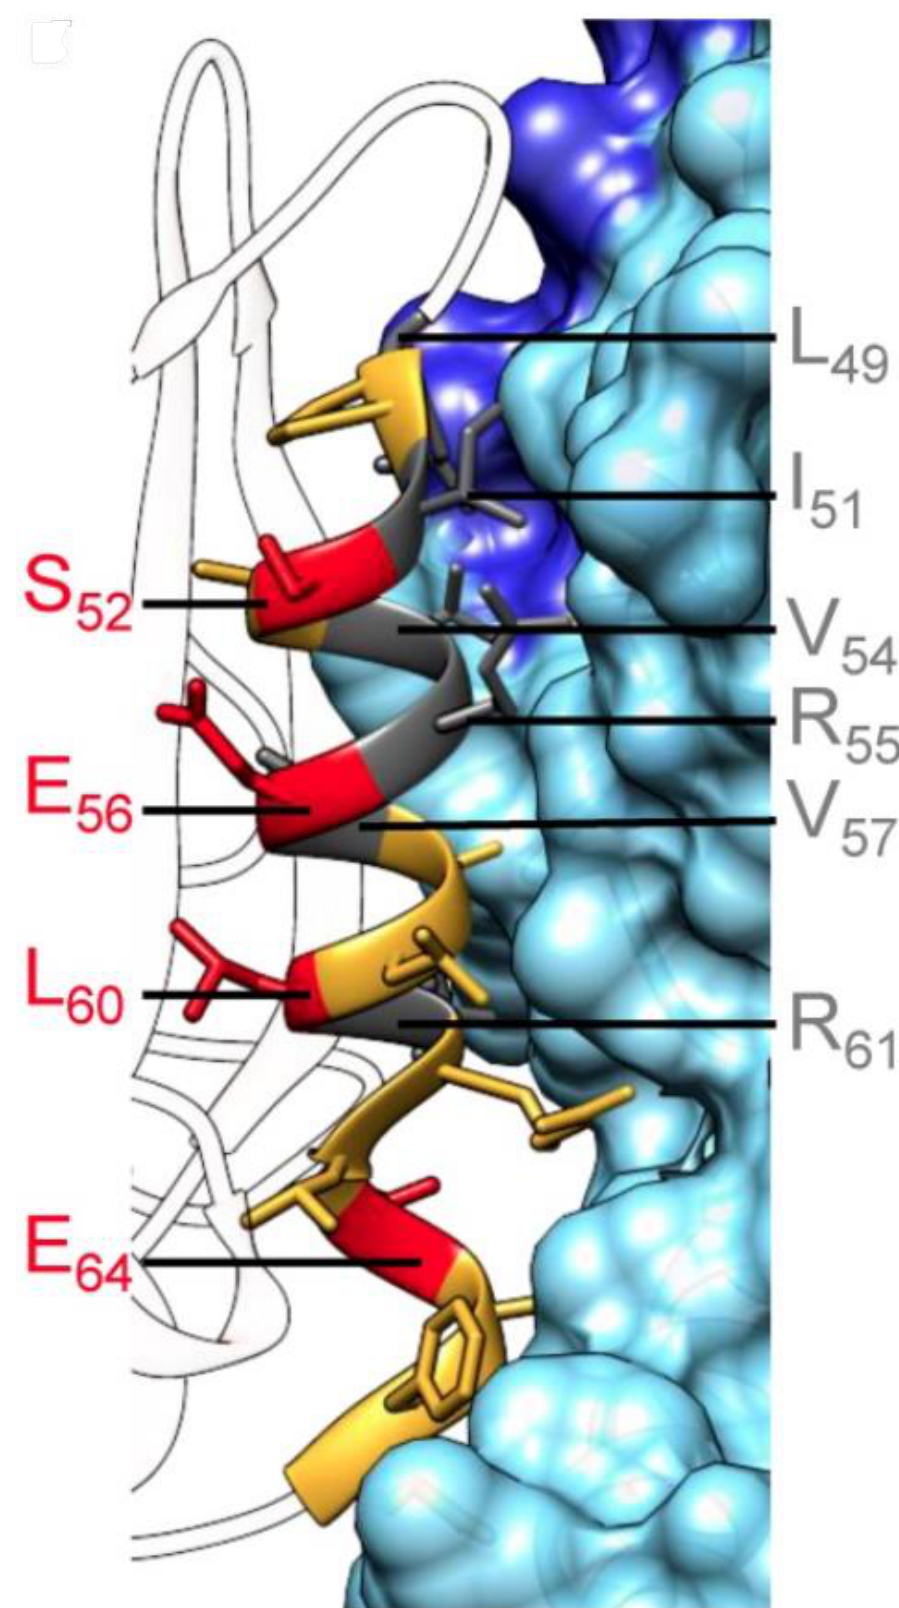
Figure 4. CDK4/Cyclin D1 is shown with the protein–protein interface helices labeled. Adapted with permission